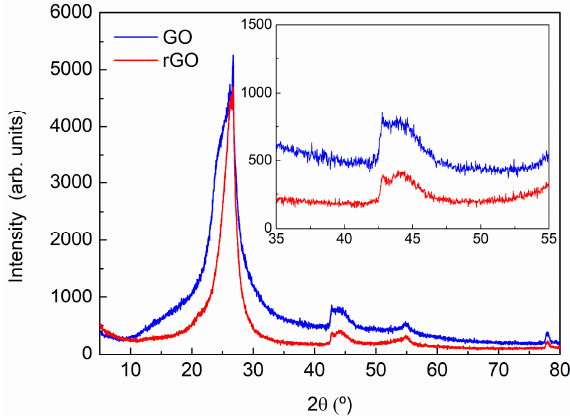
Figure 5. X-ray diffraction pattern of GO and rGO.